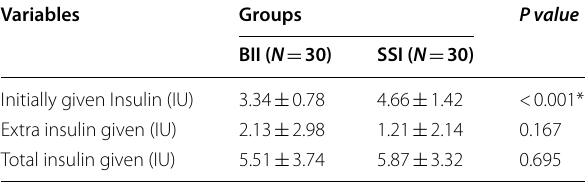
Data are presented as mean SD. P value > 0.05 is statistically non-significant. ± *indicates statistical significance. BII Bolus-insulin infusion group, SSI